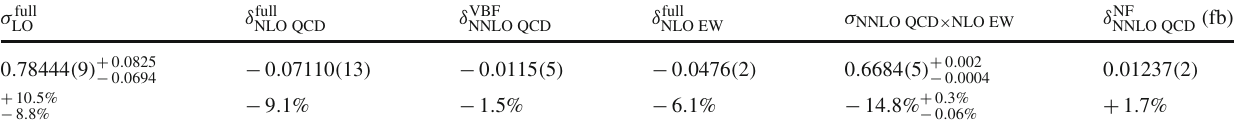
Table 1 The fiducial cross section for the process pp → HHjj, expressedin fbandinpercent,computedaccordingtoEq.(4)at14 TeV andundertheselectioncutsgiveninSect.2.Thenumbersinpercentare with respect to the LO cross section. The errors given in parenthesis are purely statistical whereas the additional uncertainties quoted for σ full